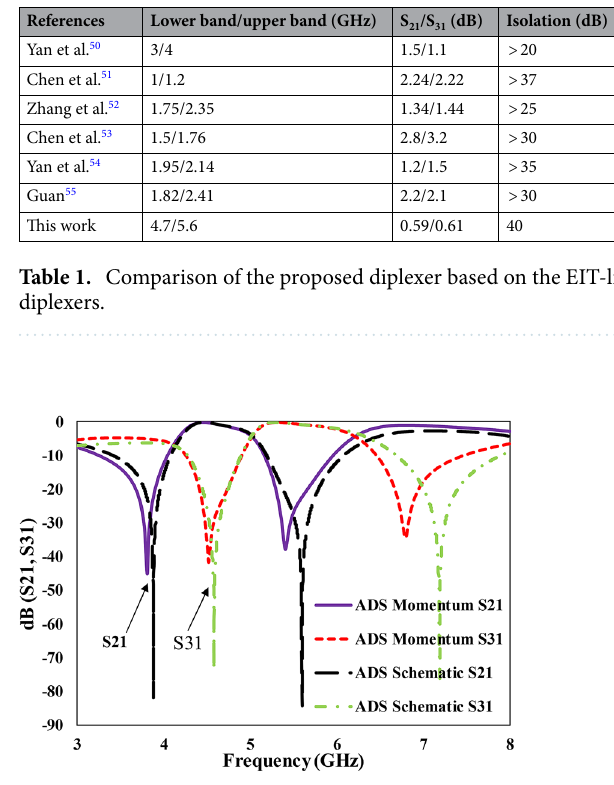
Figure 6. Demonstration of the comparison between ADS schematic and electromagnetic momentum simulations revealing that interference between the stubs is the responsible effect for the EIT-like effect as compared to